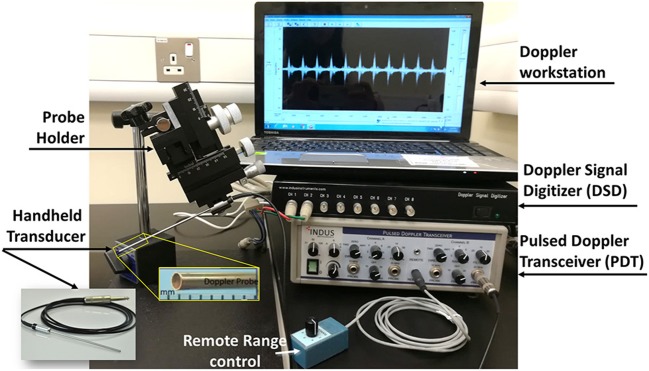
Mice Doppler system. The system is composed of a Doppler work station, signal digitizer, transceiver, a remote range control, and a handheld transducer. The interface shows a spectrogram of a signal containing a frequency of 20 kHz.